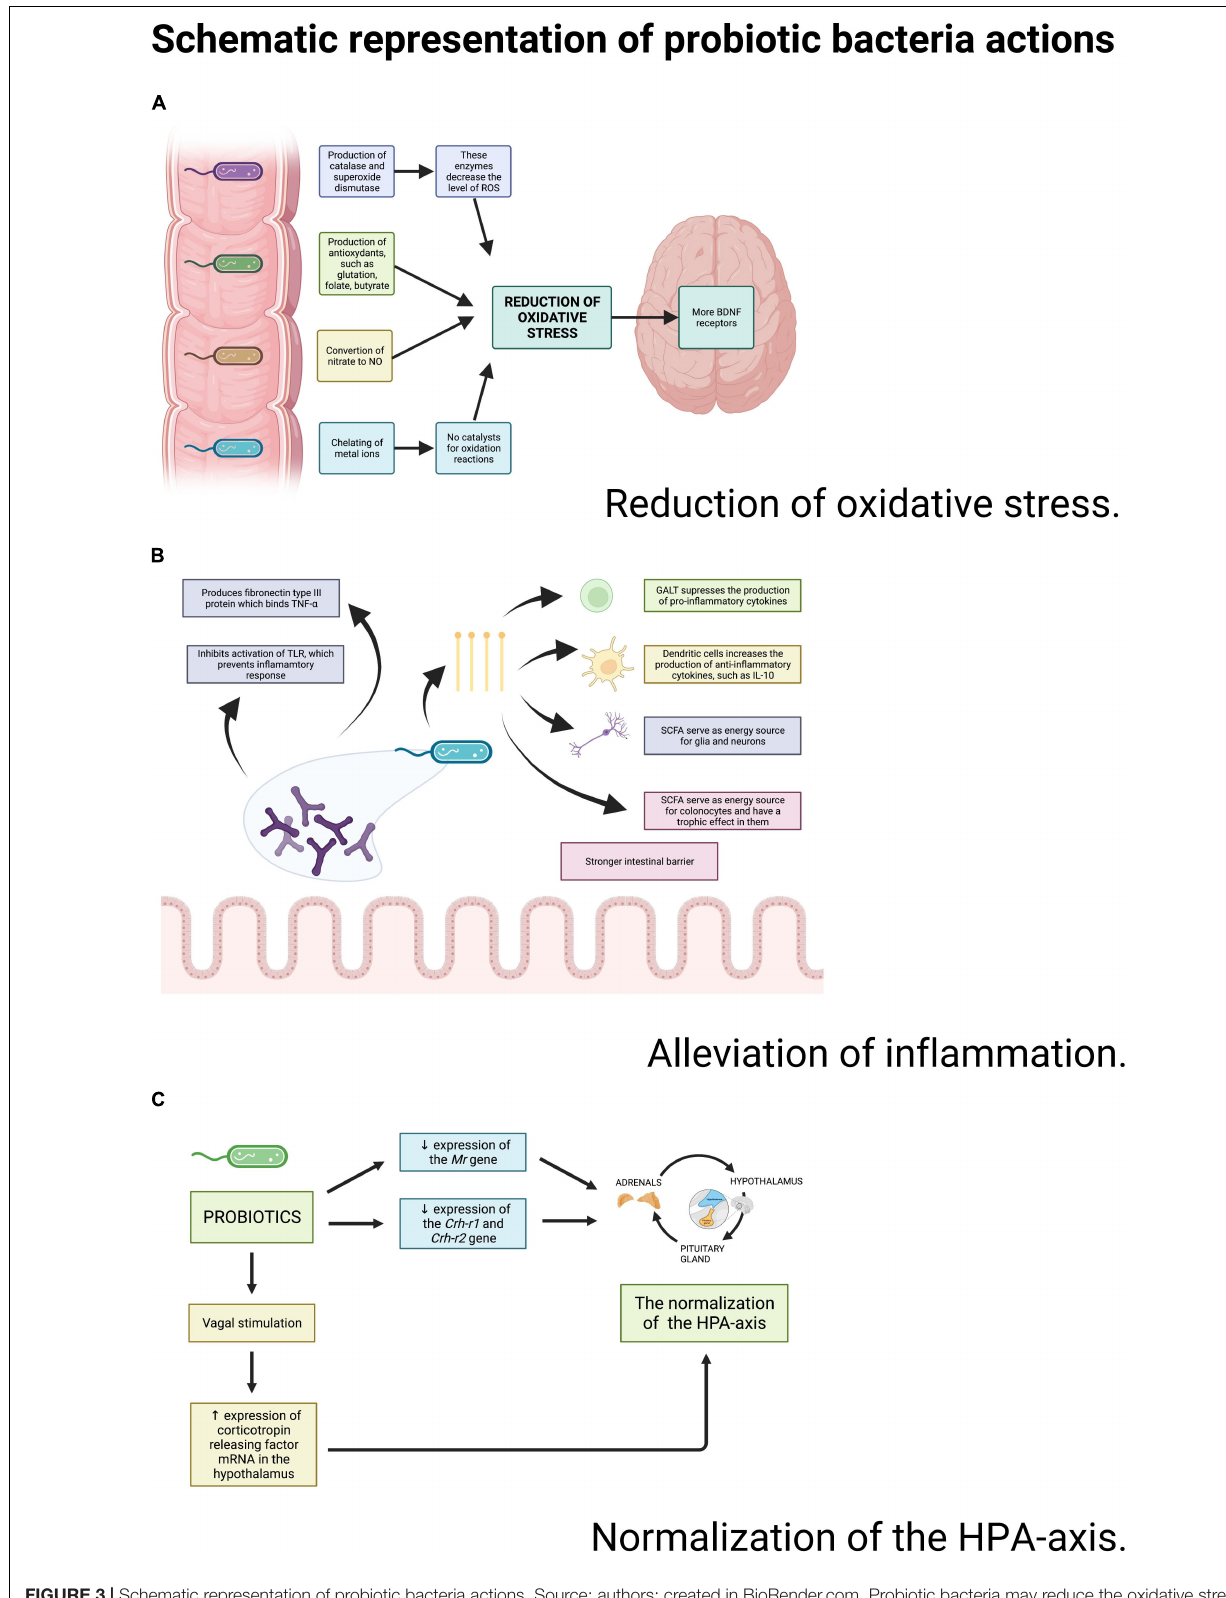
Frontiers in Psychiatry |